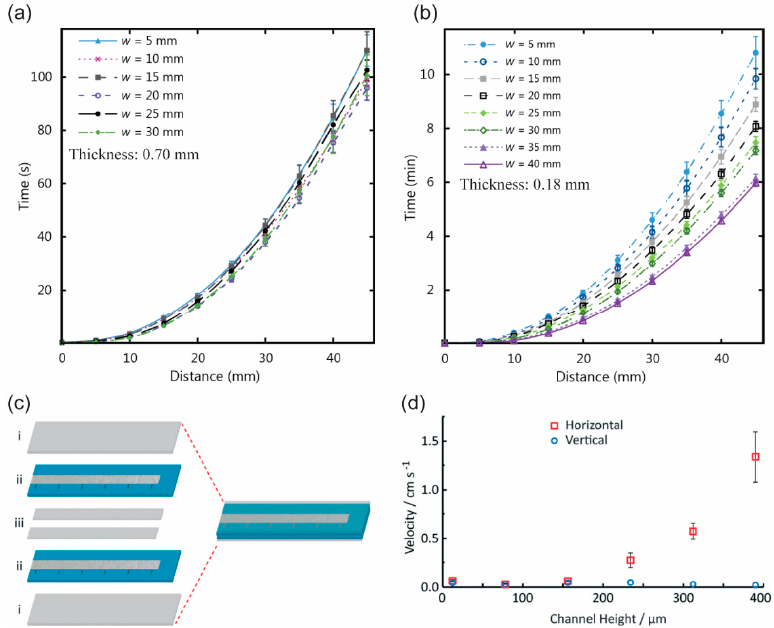
Figure 8. Influence of the geometries of the p-CFM channels on fluidic flow behavior. ( a , b ) Thickness and width of paper channels, ( c , d ) height of channel (the gap between the top and the bottom surface). ( a , b ) Reprinted with permission from the authors of [72]. Copyright 2016 under the terms and conditions of the Creative Commons Attribution. ( c , d ) Reproduced with permission from the authors of [75]. Copyright 2018 The Royal Society of Chemistry. Micromachines 2019 , 10 , x